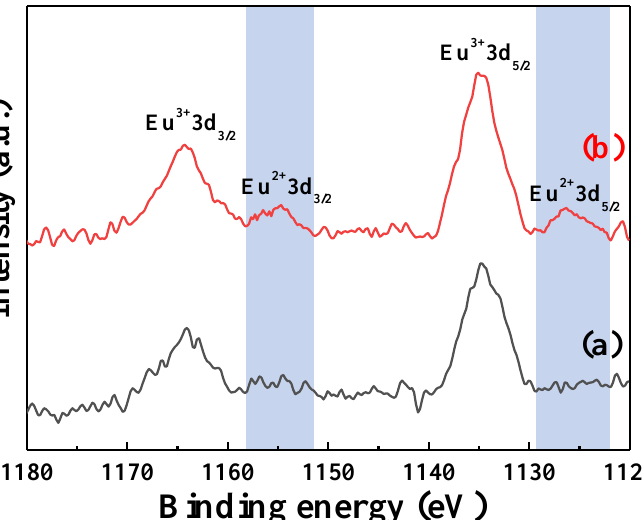
requires a higher temperature in the reducing atmosphere.